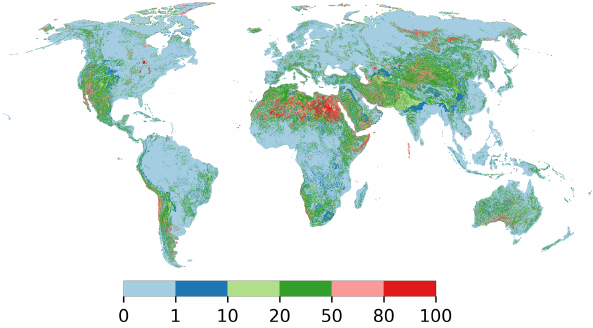
Figure 6. Percentage of all Monte Carlo realizations that resulted in a losing surface water body in a specific cell.